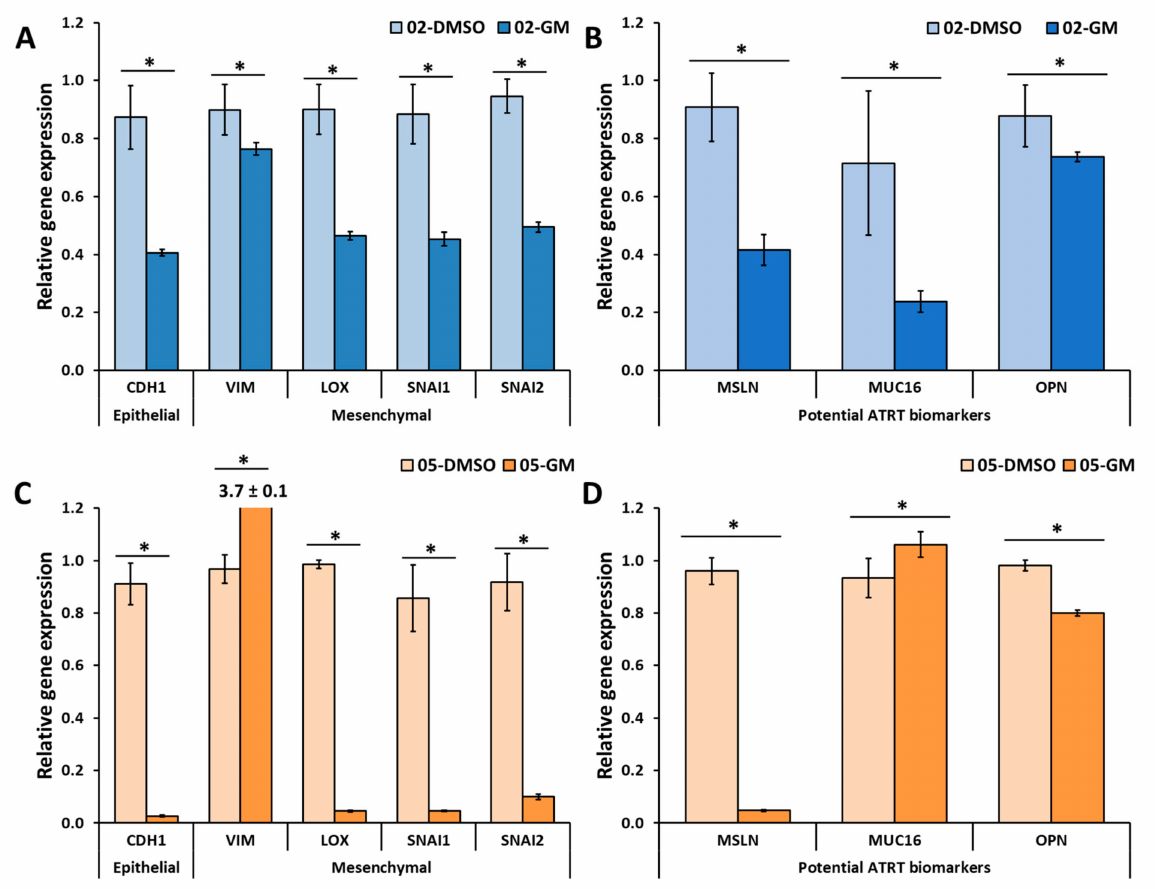
Figure 6. The effect of GM6001 on the gene expression of CHLA-02 and CHLA-05. ( A , B ) CHLA-02 and ( C , D ) CHLA-05 were treated with either DMSO or 10 µ M GM6001, a broad-spectrum MMP inhibitor. The cells were characterized for various biomarkers. *The significant difference between the control (DMSO-treated) versus the GM6001 treatment was determined based on the Student’s t -test with a p -value < 0.05. * indicates statistically significant